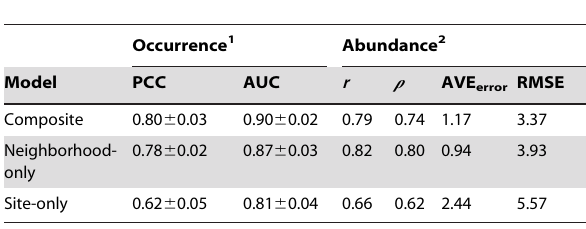
Table 4. Model prediction diagnostics for three hurdle regression models predicting the occurrence (binomial) and abundance (count) of steelhead redds in the John Day River basin,